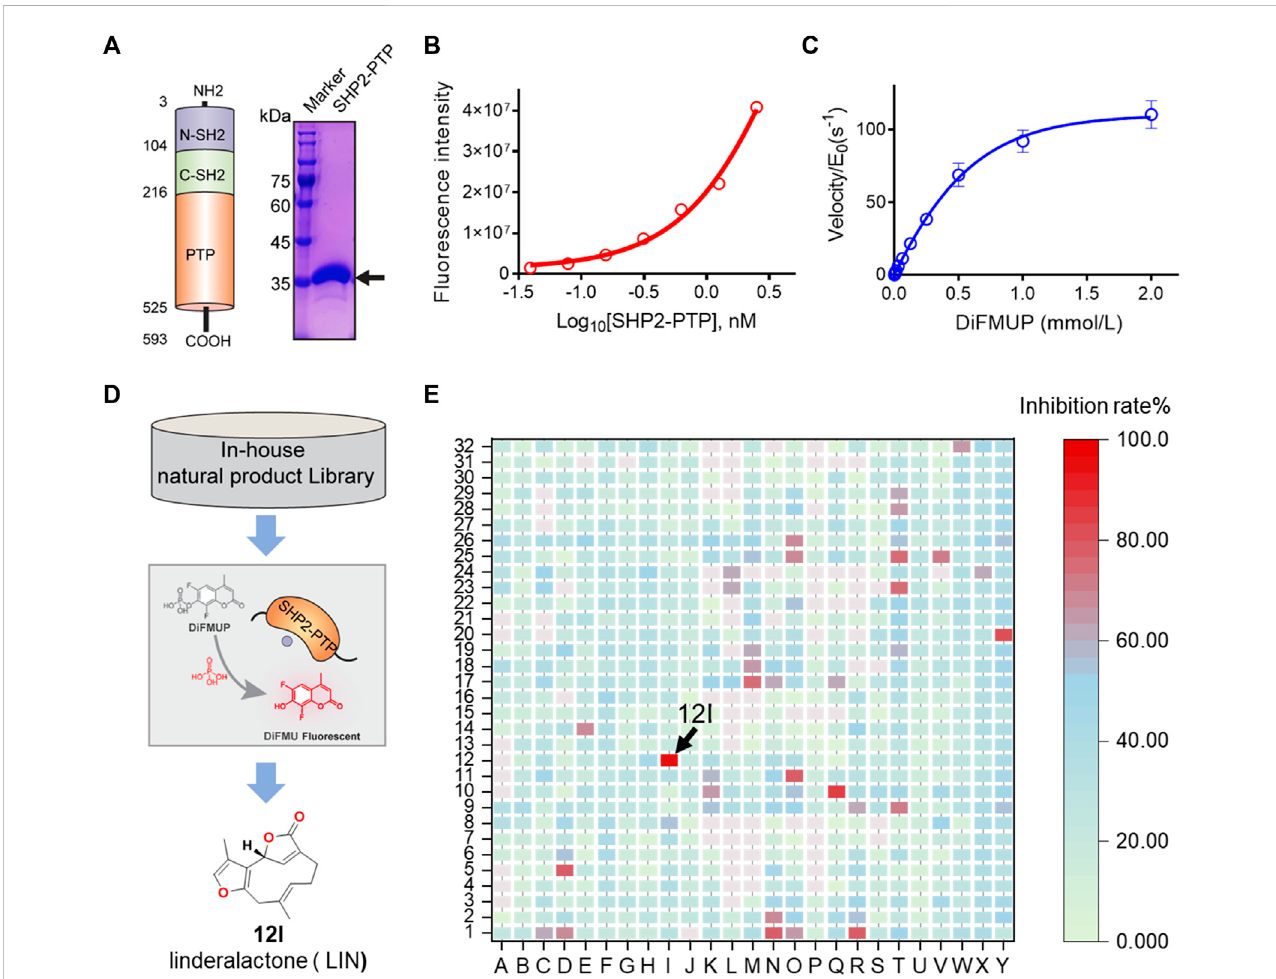
FIGURE 1 HTS and identi fi cation of novel SHP2 inhibitors from natural product library. (A) Schematic illustration of three SHP2 subdomains containing N-SH2, C-SH2,andPTPdomainshowninblue,green,andorange,respectively.ThePTPdomainofSHP2wasexpressedandpuri fi ed,andthepurityofthehis-tagged labelled SHP2 PTP domain are evaluated by SDS-PAGE and Coomassie blue staining with a molecular weight of approximately 38.0 kDa. (B) The dephosphorylation activity of rhSHP2-PTP with the protein concentrations ranging from 0 to 2.50 nM. (C) Enzyme kinetics of substrate DiFMUP dephosphorylation bySHP2-PTP. (D,E) Drugscreeningparadigm for SHP2inhibitorHTS froman in-housenatural productlibrary (800compounds)usingthe DiUFMP assay, leading to the identi fi cation of linderalactone (12I) as a novel SHP2